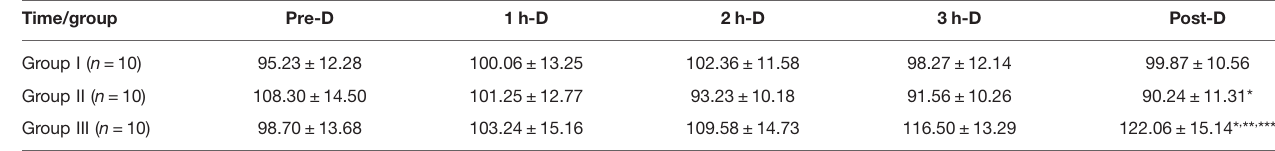
TABLE 3 | Comparison of MAP during HD in group I, group II and group III (Mean, SD).